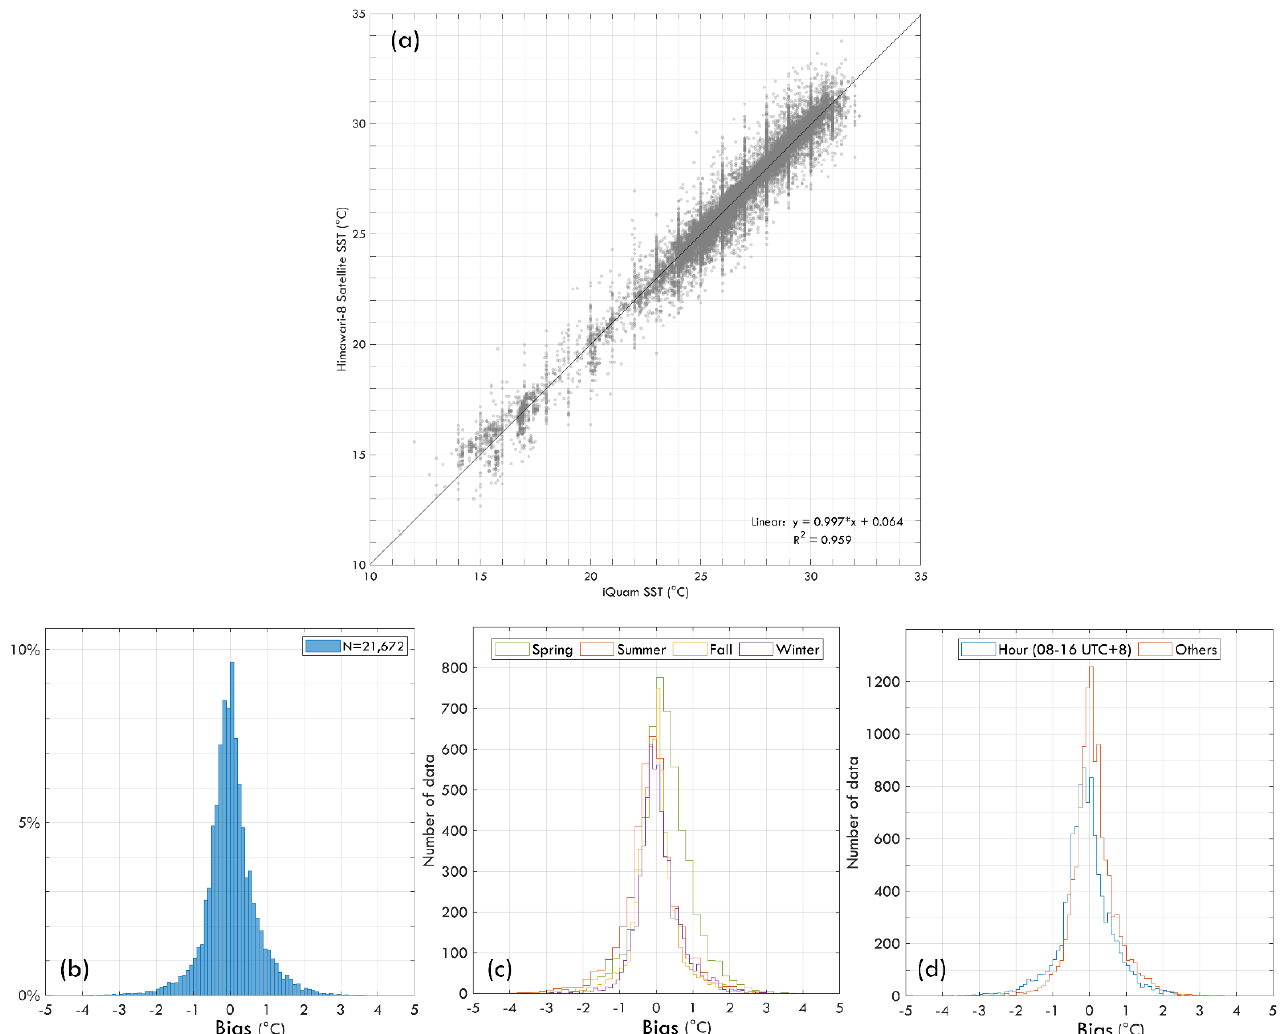
Figure 5. (a) Comparison of SST data between the iQuam and Himawari-8 satellite, and the histogram of bias for bulk- skin SST data pairs (b) for all samples, (c) in four seasons, and (d) during daytime and nighttime. A positive value of bias indicates that bulk SST (iQuam) is greater than skin SST